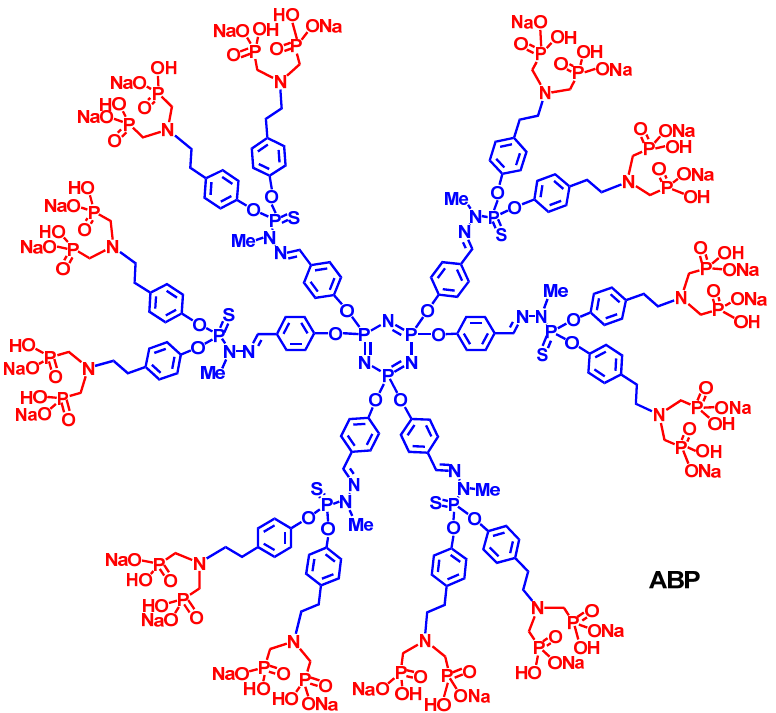
Figure 1. Structure of dendrimer ABP . Core (cyclotriphosphazene) and branches (phosphorhydrazones) are in blue, surface end groups (azabisphosphonates) are in